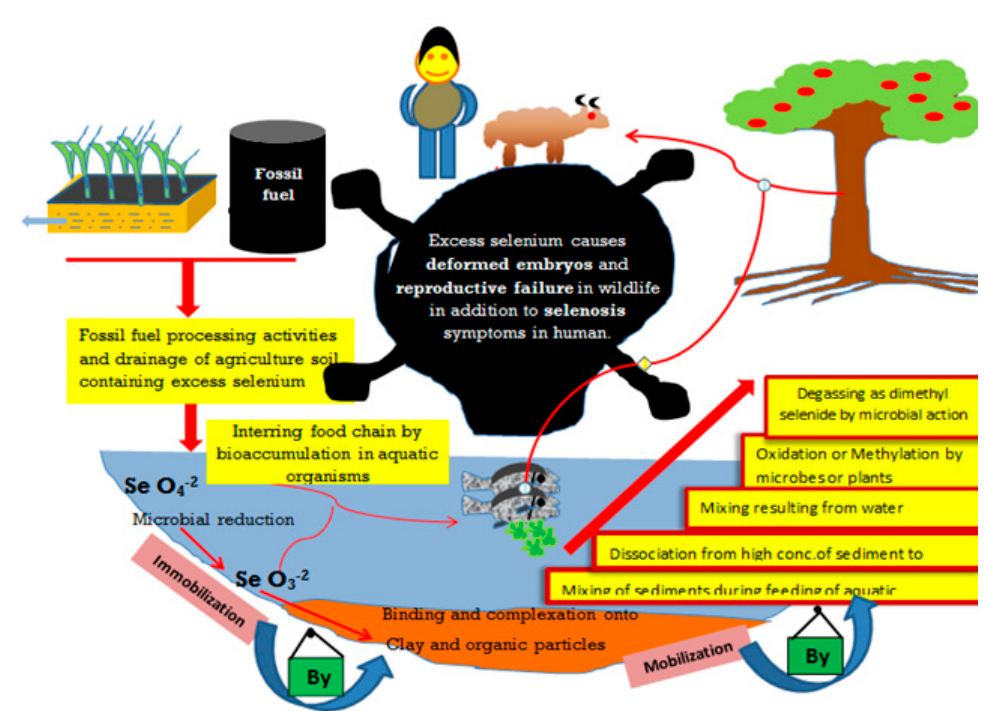
Figure 2. Possible fates of selenium in the environment. Selenium could be released into the aquatic environment from industrial and agricultural activities. The excessive application of Se as fertilizer may lead to environmental hazards, which may be controlled by immobilization and mobilization reactions in soil, driven by soil clay and organic matter content as well as microbial activities. These Se-pathways may threaten human and animal health.